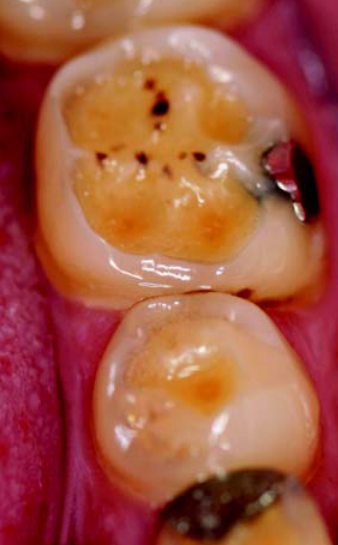
FIGURE 2- Clinical appearance of tooth wear in dentin in a 25-year-old athlete due to frequent consumption of